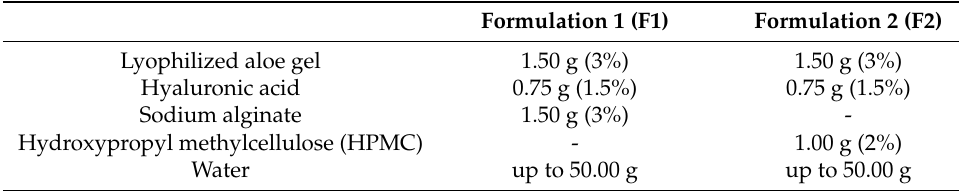
Table 1. Chemical composition of